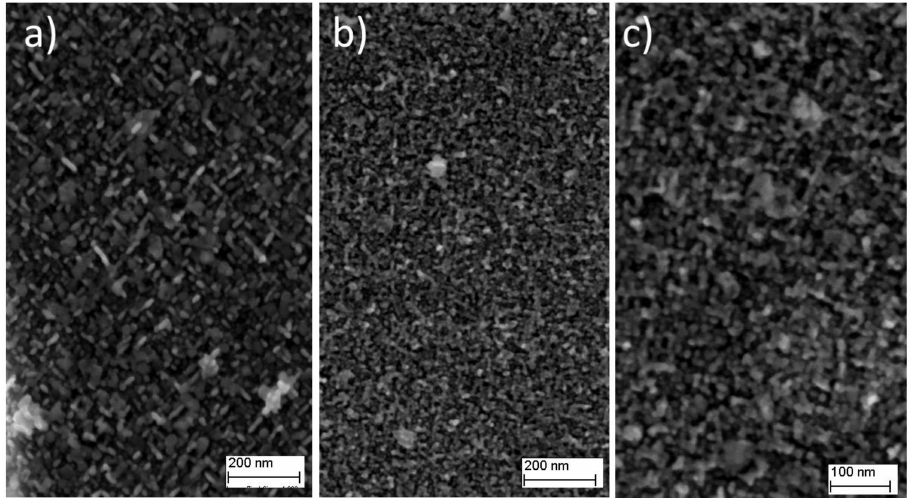
Figure 13. FESEM image of ( a ) 4AH and ( b , c ) 1DAH samples of micro-LPBF Inc718.